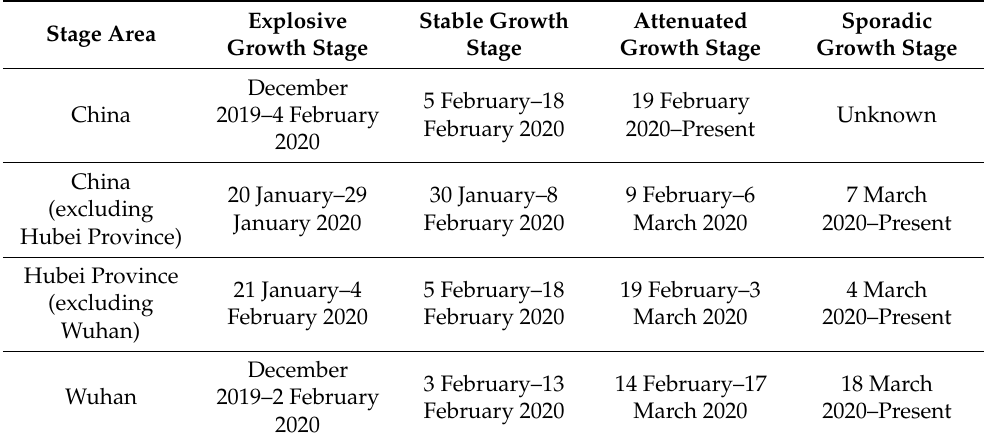
Table 1. Four stages of transmission of COVID-19 in